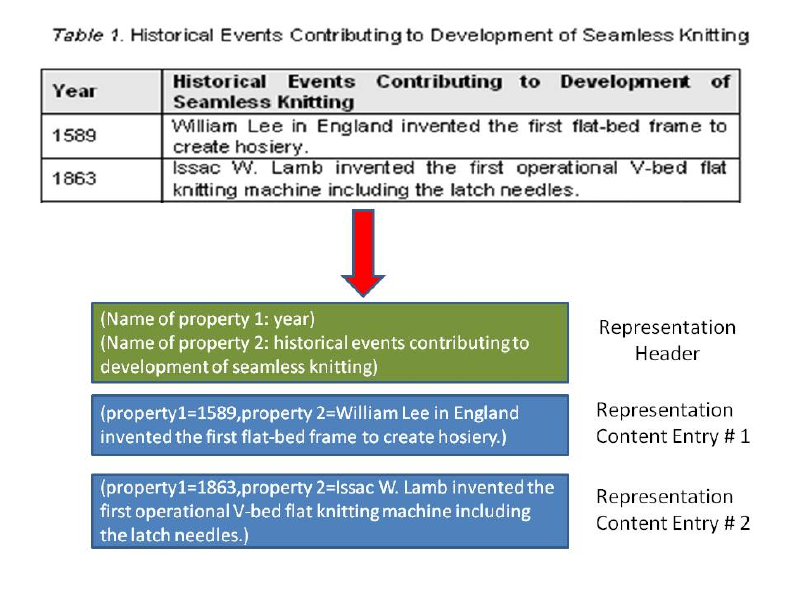
Figure 1. Metadata